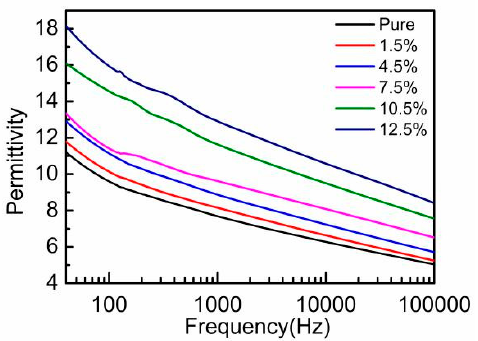
Figure 9. Relative dielectric constant versus frequency curves of PVDF-TrFE/nano-ZnO films with different nano-ZnO contents.